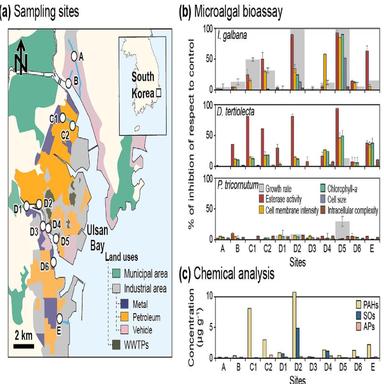
(a) Map showing the sampling sites and surrounding activities in Ulsan Bay. (b) Inhibition of growth and cell viability (esterase activity, cell membrane intensity, chlorophyll a autofluorescence, cell size, and intracellular complexity) in the three microalgal species (Isochrysis galbana, Dunaliella tertiolecta, and Phaeodactylum tricornutum) after exposure of raw extracts of sediments. (c) Concentrations of PTSs (PAHs: polycyclic aromatic hydrocarbons; SOs: styrene oligomers; APs: alkylphenols) in the sed